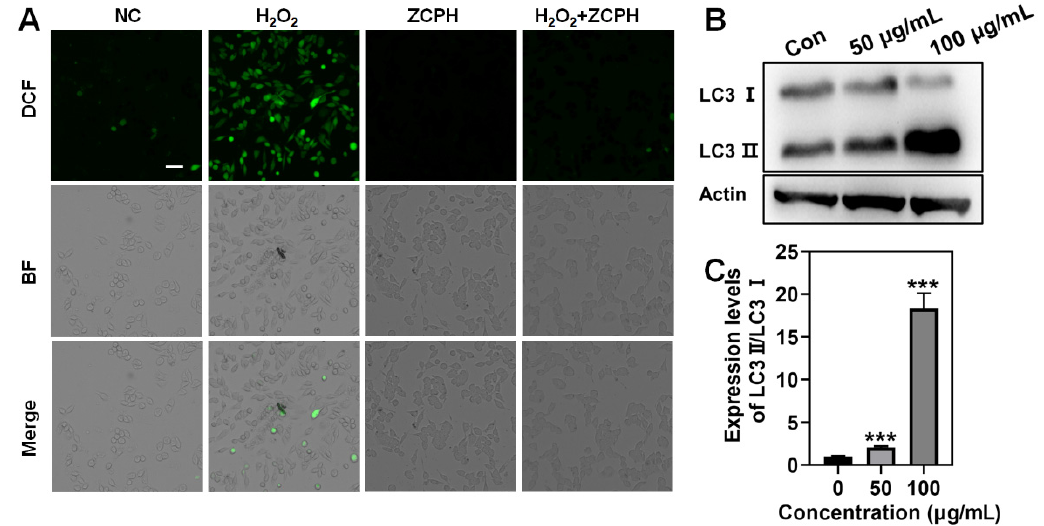
Figure 5. ( A ) Representative ROS staining of SKOV3 cells with DCFH-DA probe. ( B ) Western blot- ting analysis of LC3 lipidation and ( C ) the corresponding quantitative data after treatment with ZCPHs for 24 h . Scale bar: 50 µm. Statistical significance was calculated via Student’s t test, *** p < 0.001.